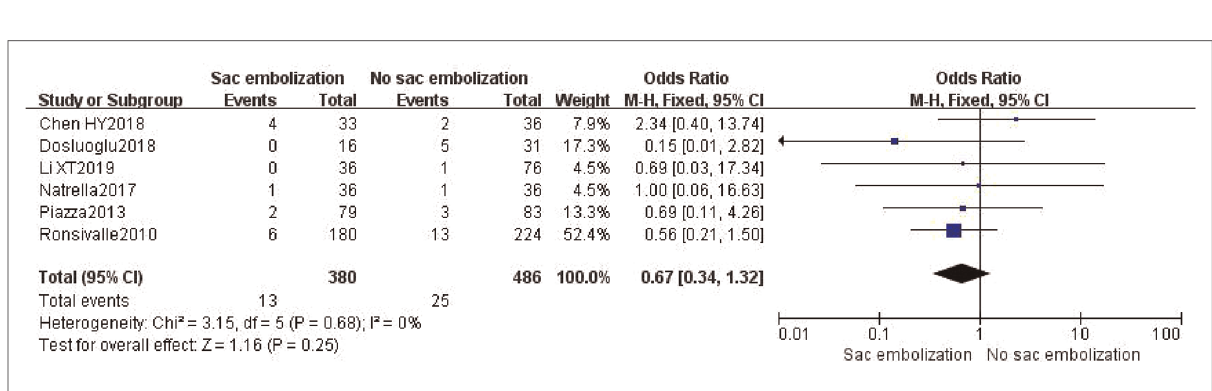
FIGURE 5 Incidence of other endoleaks in the embolization group compare with the non- embolization